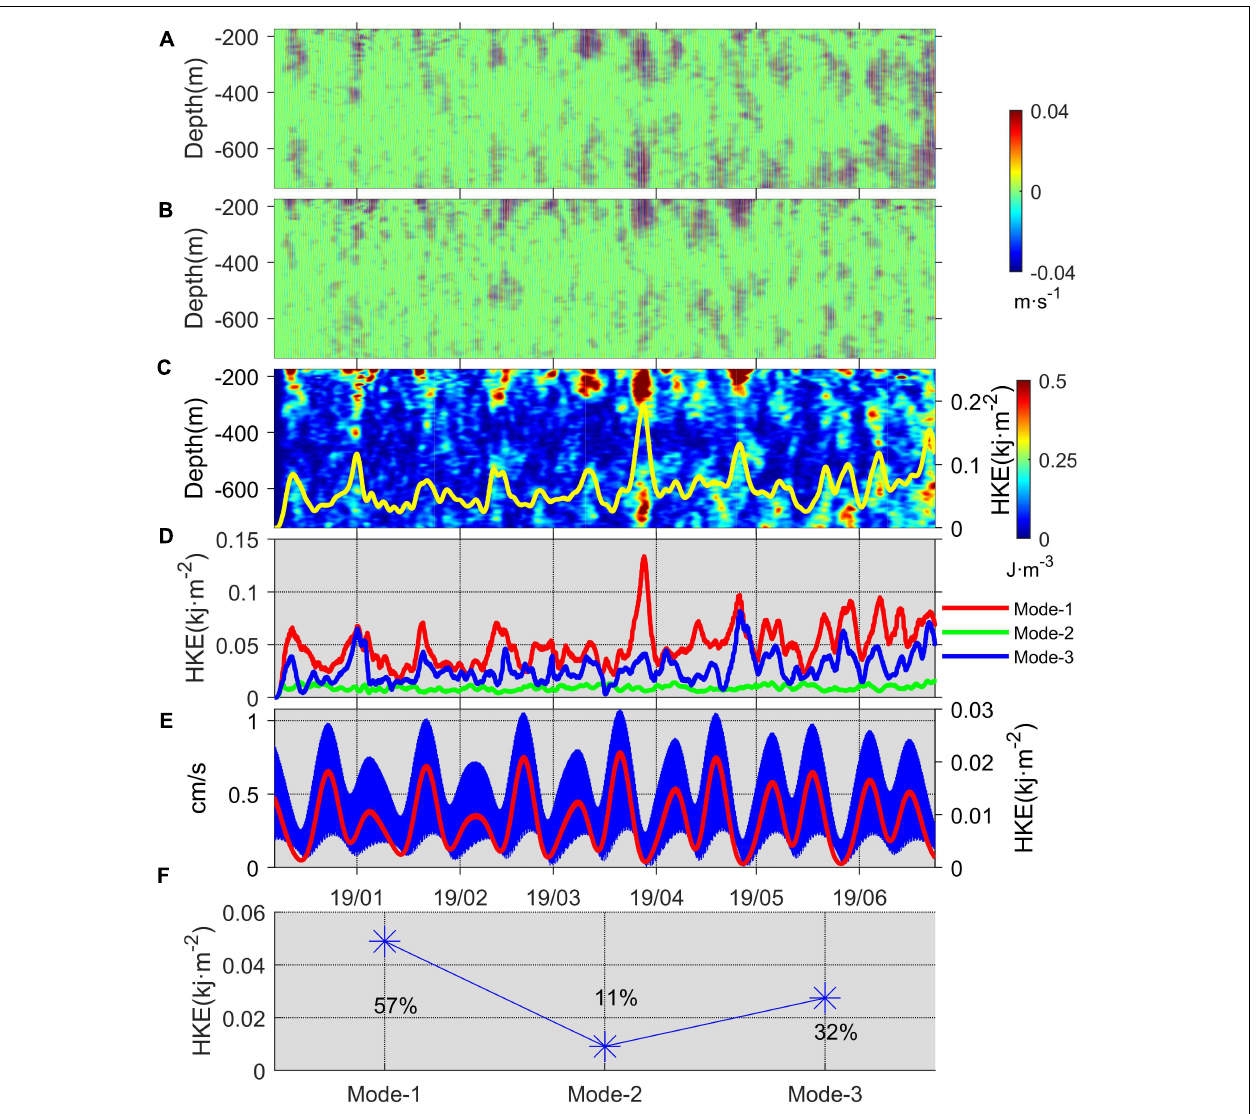
FIGURE 8 | Time series of the zonal velocity of semidiurnal ITs (A) and meridional velocity of semidiurnal ITs (B) . Distribution of semidiurnal ITs HKE (C) , yellow line for vertical integration. Time series of mode-1 (red), mode-2 (green), and mode-3 (blue) semidiurnal HKE (D) . Barotropic current amplitude (blue) and HKE (red) at semidiurnal band (E) . Horizontal labels mark the start of the month. Proportion of mode-1, mode-2, and mode-3 (F)